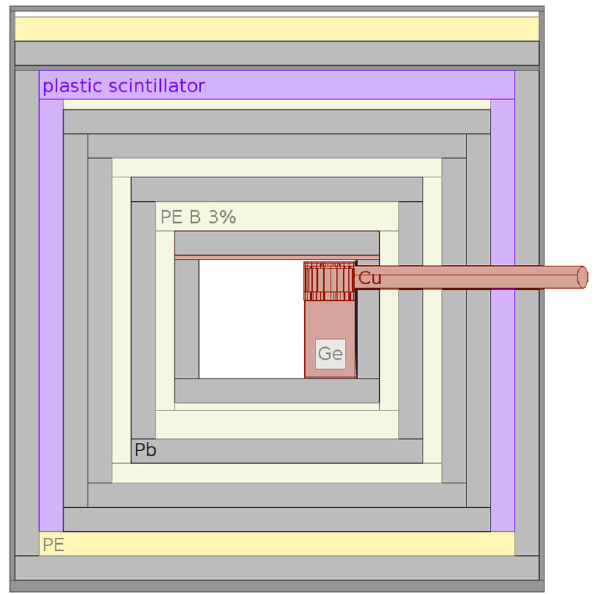
Fig. 9 SideviewoftheimplementationoftheCONUSshieldgeometry and exemplary one detector within. The HPGe diode is marked in gray inside the Cu cryostat. The shield is surrounded by a stainless steel cage ensuring safety requirements (dark